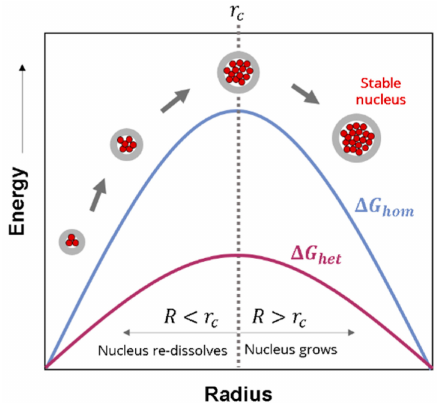
Figure 3. Schematic representation of the energy as a function of the nucleus radius, adapted from reference